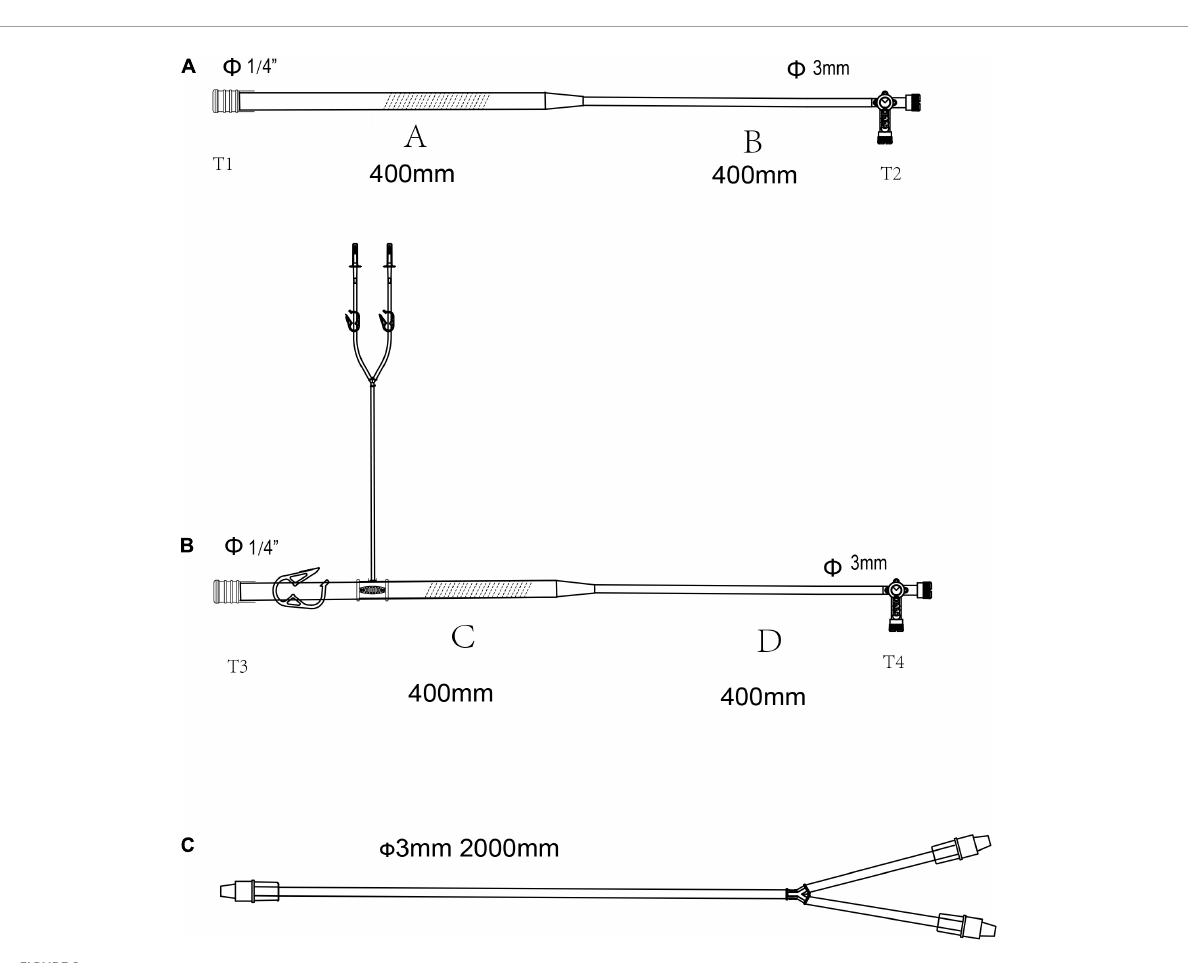
FIGURE2 The pipelines for selective organ perfusion in the LHB circuit. (A) Line for selective visceral perfusion. (B) Line for selective kidney perfusion. (C) Y-type line connected to the T2 celiac axis for SMA and celiac axis perfusion or T4 to renal arteries for the selective perfusion. The line marked oblique dotted line is used for roller